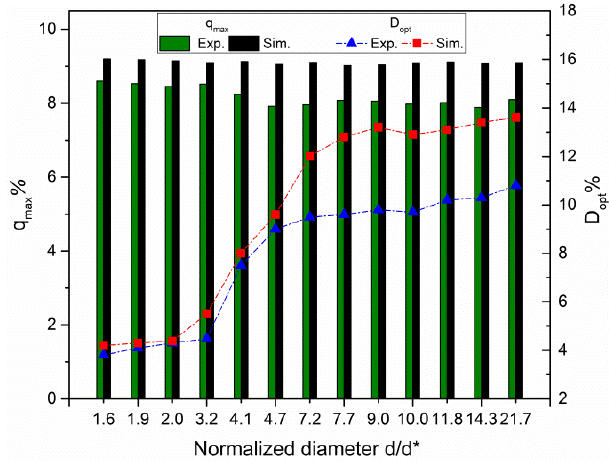
Figure 7. E ff ect of droplet initial diameter on q max and D opt . Figure 7. Effect of droplet initial diameter on q max and D opt